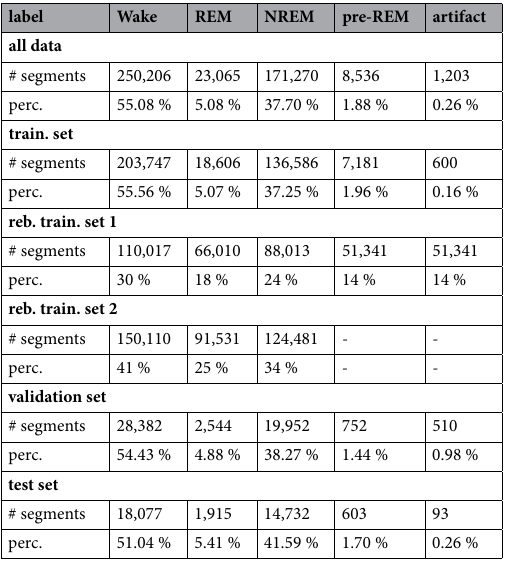
Table 2. Statistics of labeled segments of the whole dataset (“ all data ”), of the training set (“ train. set ”), the rebalanced training sets (“ reb. train. set 1 and 2 ”), the validation set (“ validation set ”), and the test set (“